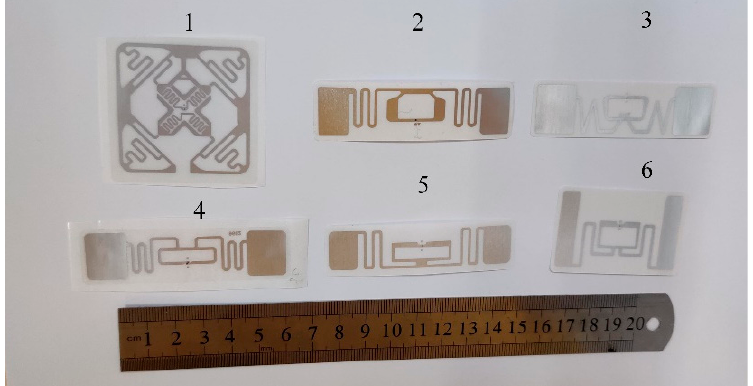
Figure 2. UHF RFID tags selected in the experiment (labeled 1–3 from left to right on the top line, and 4–6 from left to right at the bottom).